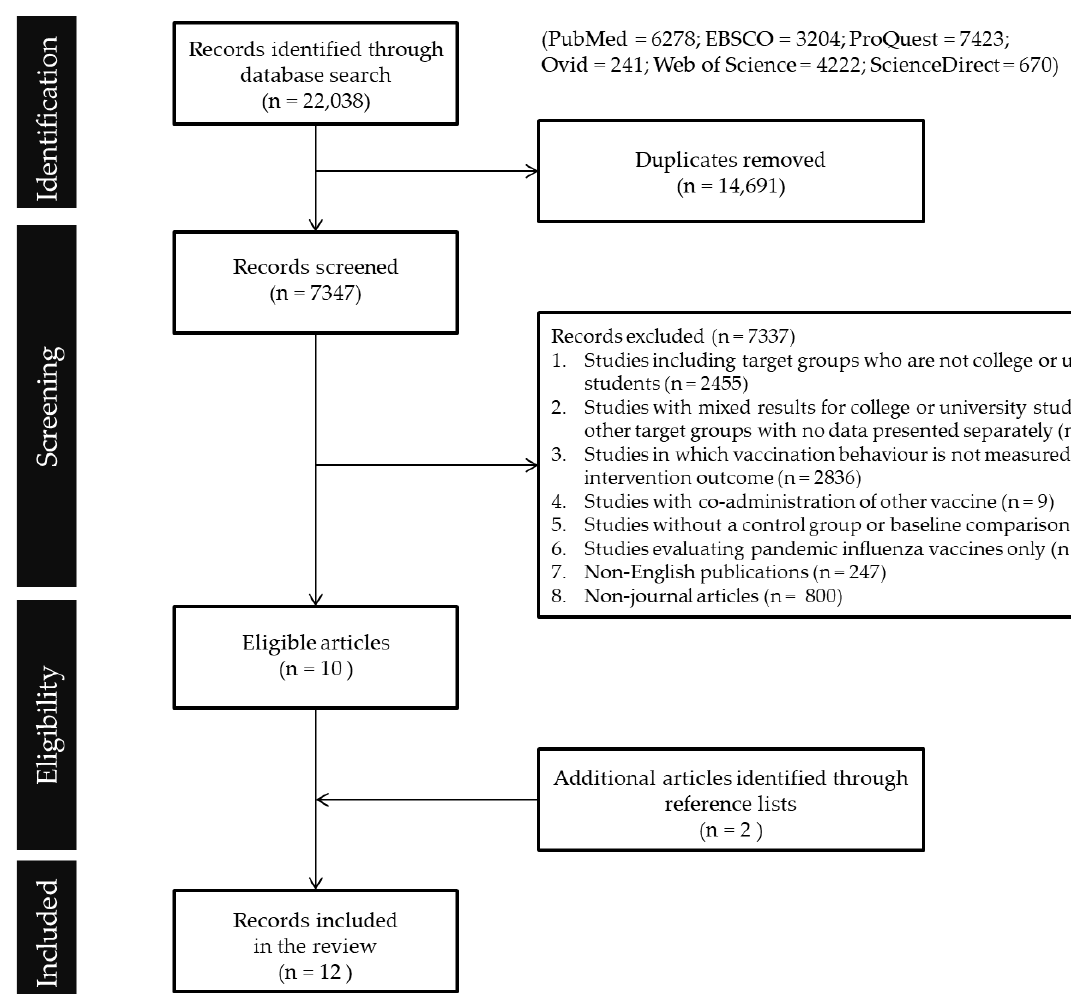
Figure 1. Flowchart of the literature search process (PRISMA).